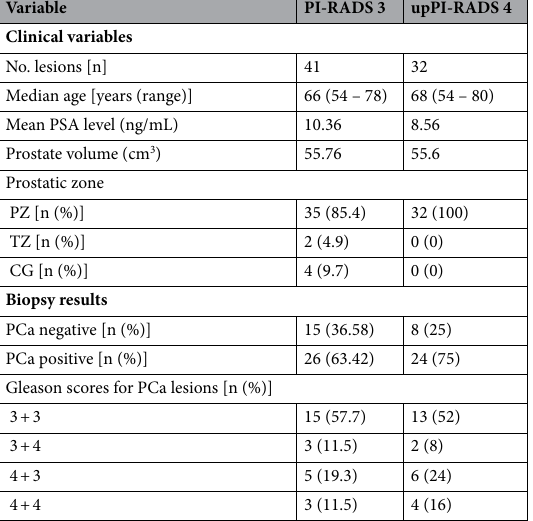
Table 1. Characteristics of included patients. PSA prostate-specific antigene, PCa prostate cancer, PZ peripheral zone, TZ transition zone, CG central gland, PI-RADS prostate imaging-reporting and data